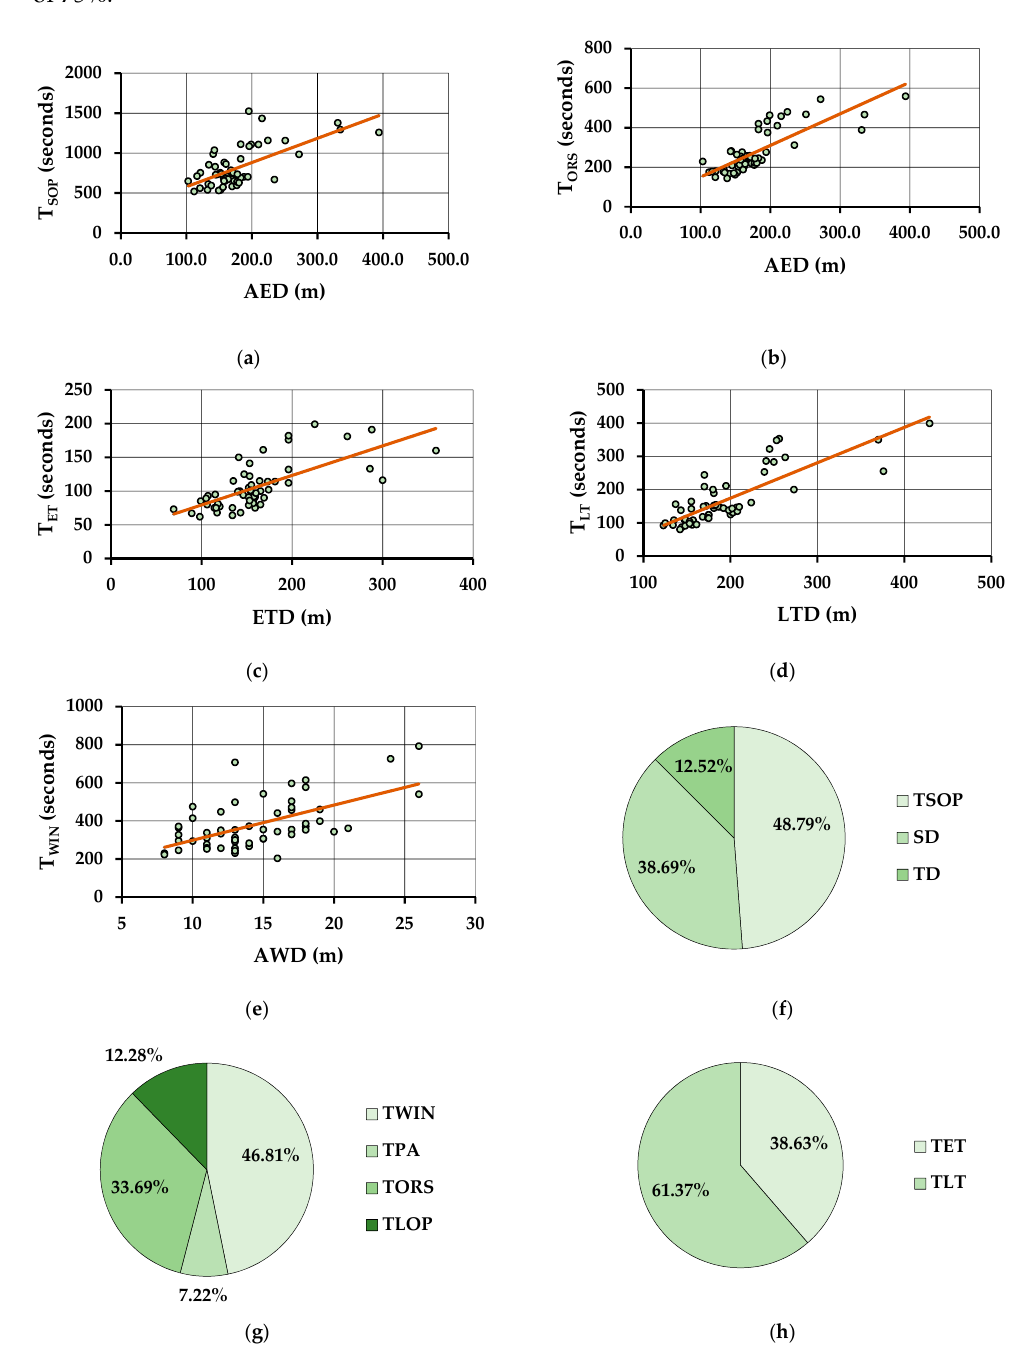
Figure 4. Time consumption estimates: ( a ) variation in time consumption of skidding operations (T SOP ) as a function of average extraction distance (AED); ( b ) variation in time consumption of on-road skidding (T ORS ) as a function of AED; ( c ) variation in empty turn time (T ET ) as a function of empty turn distance (ETD); ( d ) variation in loaded turn time (T LT ) as a function of loaded turn distance (LTD); ( e ) variation in winching time (T WIN ) as a function of average winching distance (AWD); ( f ) share of delay-free time (T SOP ) in the total observed time; ( g ) share of operational time (T WIN , T PA , T ORS , T LOP ) in the delay-free time (T SOP ); ( h ) share of empty (T ET ) and loaded turn (T LT ) time in the on-road skidding time (T ORS